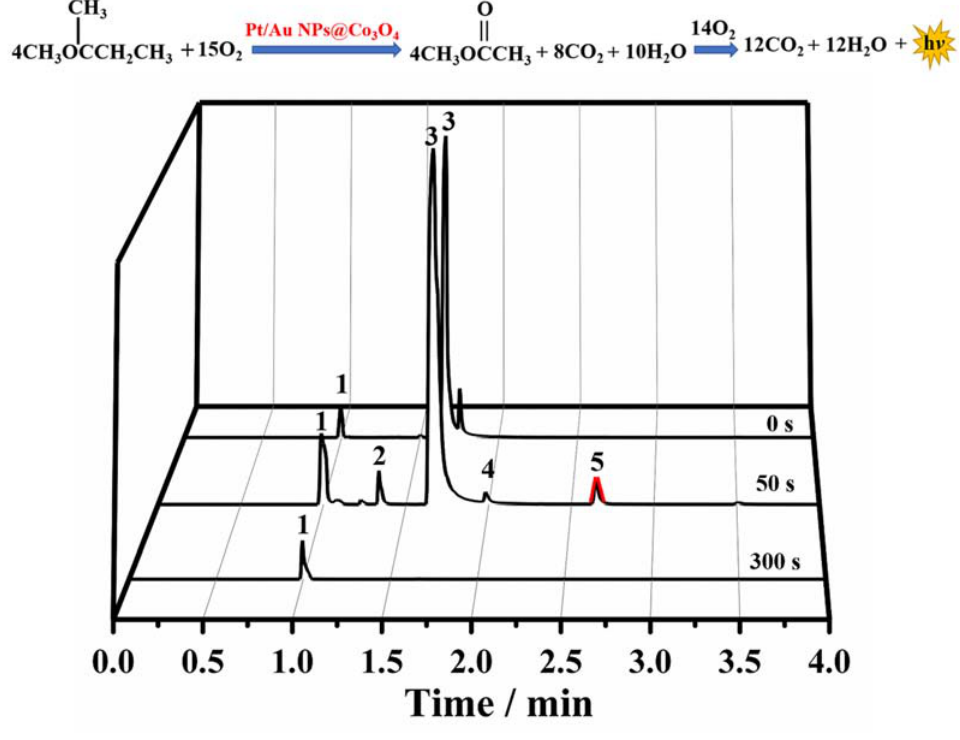
Figure 6. Possible mechanism of MSBE CTL oxidation reaction. Peak 1: CO 2 , Peak 2: